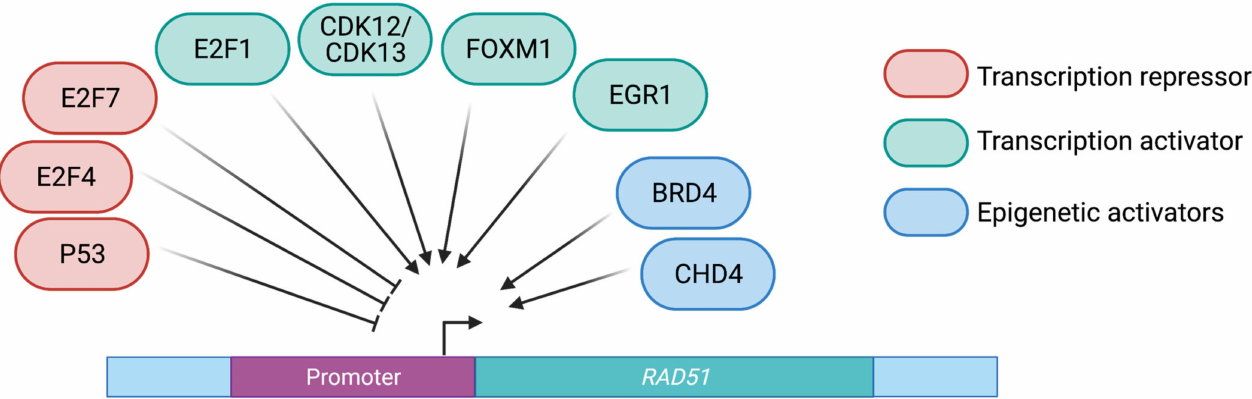
Figure 3. Identified regulators of RAD51 transcription. The DNA sequences containing the RAD51 promoter and the gene are represented as a purple box and a green box,